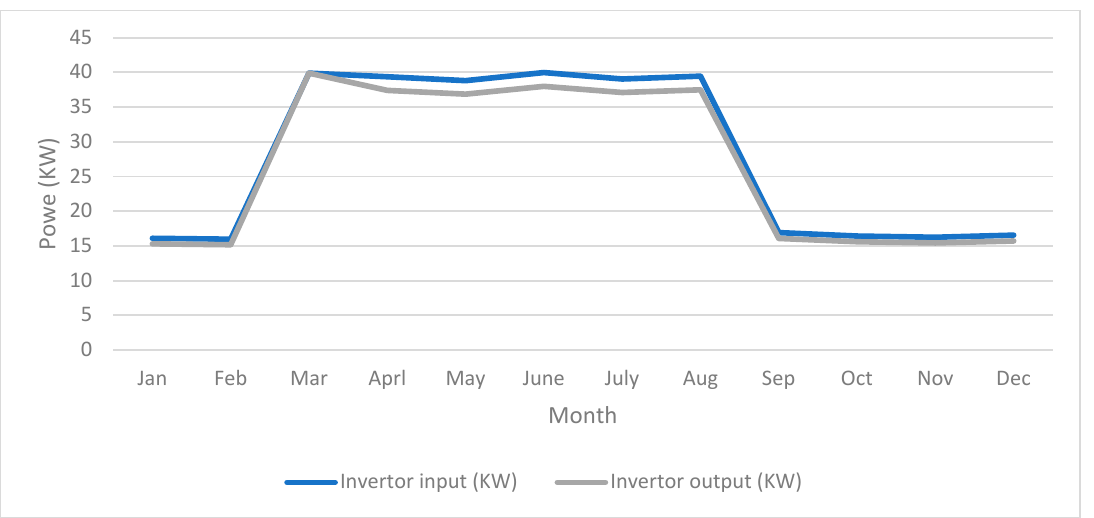
Figure 9. Monthly avg. fuel consumption (L).